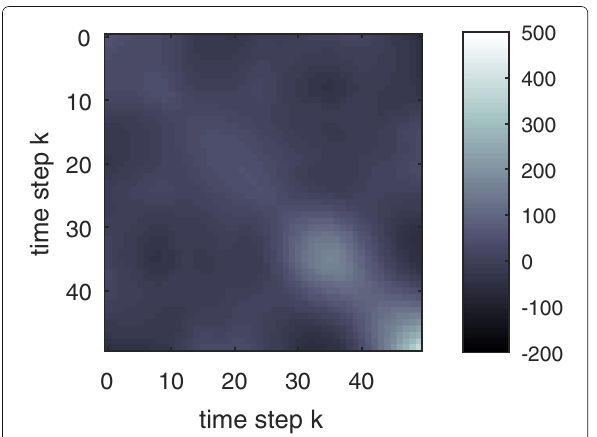
Fig. 13 EnKF (20 members) position covariance matrix cov ( x i ,x j ) after including all measurements in the order y 1 , ... y L